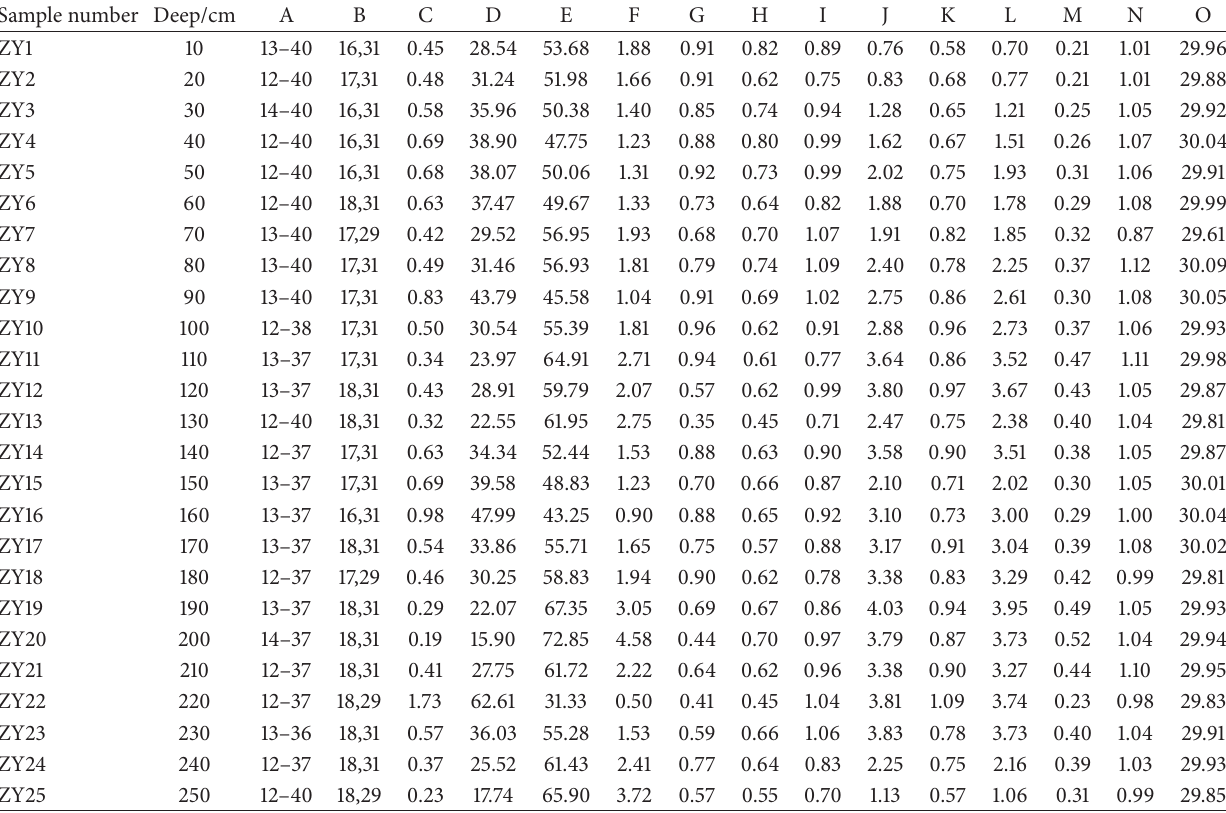
Table 2: Geochemical parameters of n-alkanes and isoprenoid alkanes of sediment core samples. Sample number